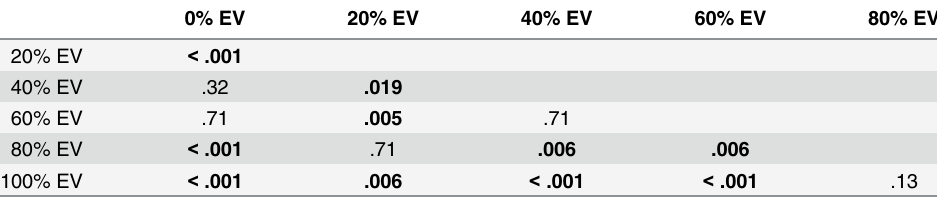
Table 1. Corrected t -test p -values for pairwise comparisons of preference rating scores from Fig